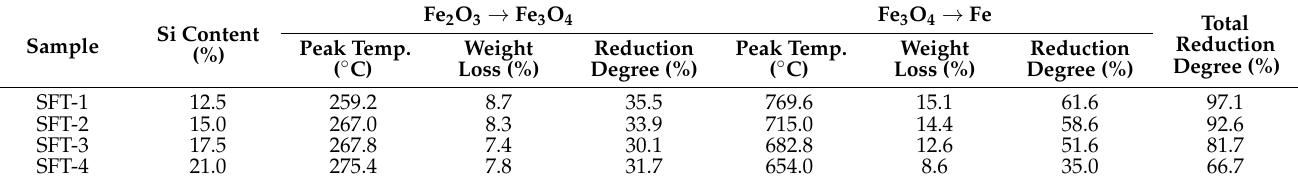
Table 3. H 2 -TG results of the prepared